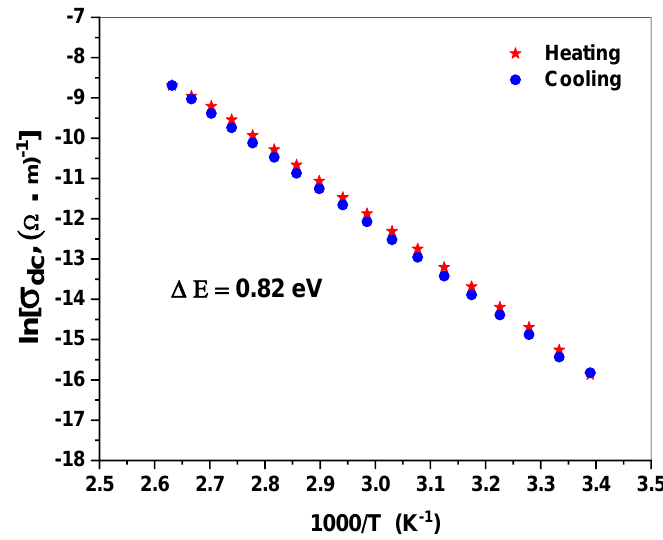
Figure 19. Dependence of ln(𝜎 𝑑𝑐 ) on inverse temperature for compound 4 thin film.